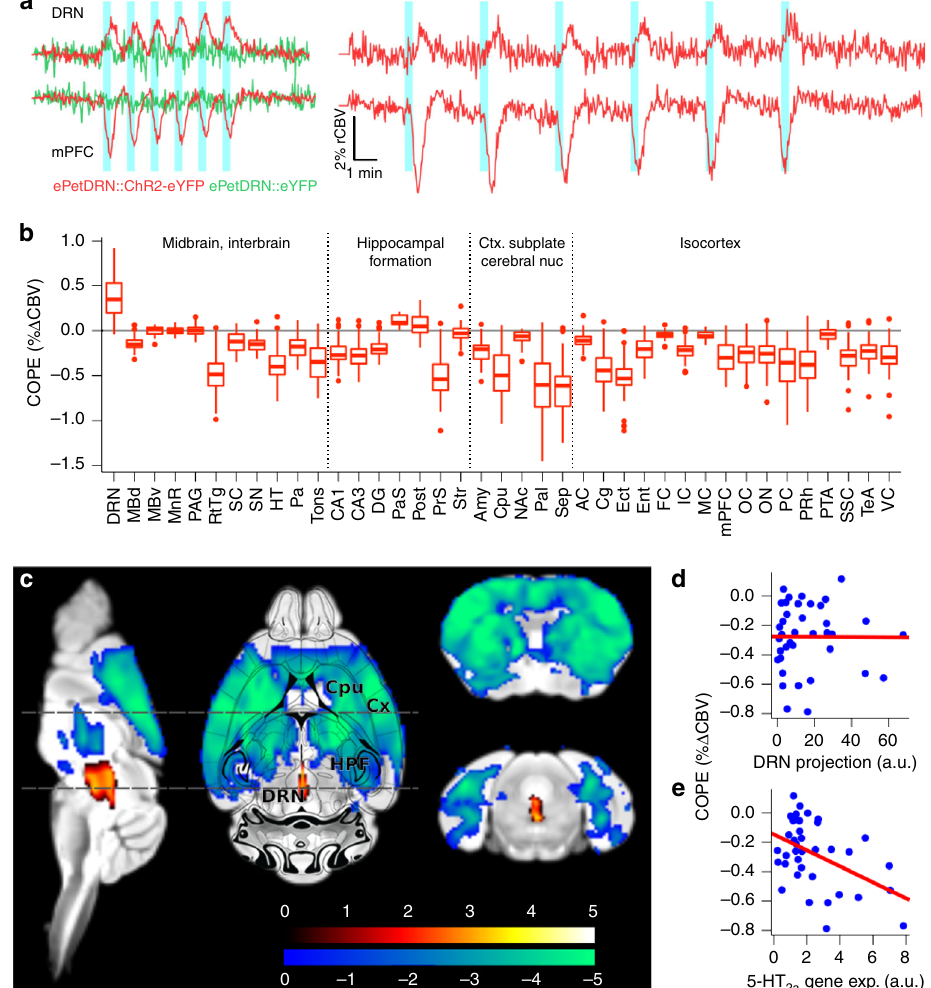
Fig. 2 A whole-brain functional map of the DRN 5-HT circuit. a CBV traces from the DRN and medial prefrontal cortex (mPFC) during block stimulation with blue light (20 Hz, 5 ms pulse width, 6 × 20 s trains) during the short ( ePet DRN ::ChR2-eYFP , n = 10, ePet DRN ::eYFP , n = 4) and long ( ePet DRN ::ChR2-eYFP , n = 7) fMRI protocols. b Contrast of parameter estimates (COPEs) extracted across 39 ROIs from ePet DRN ::ChR2-eYFP using the short protocol ( n = 10). They denote the relative response amplitude across the brain. Bound of box and centre line represent 25th, 50th, 75th percentiles, whiskers represent 1.5*inter-quartile range. c Second level voxel-wise analysis of ePet DRN ::ChR2-eYFP ( n = 10) against ePet DRN ::eYFP ( n = 4). Cx cortex, Cpu caudate-putamen, HPF hippocampal formation, DRN dorsal raphe nucleus. Colour scale = t -statistic (non-parametric test, p ≤ 0.05, cluster corrected). d , e COPEs extracted from 38 ROIs compared with d DRN projection fi eld estimated with viral tracer and e 5-HT 2A gene expression estimated with in-situ hybridization, both obtained from AIBS